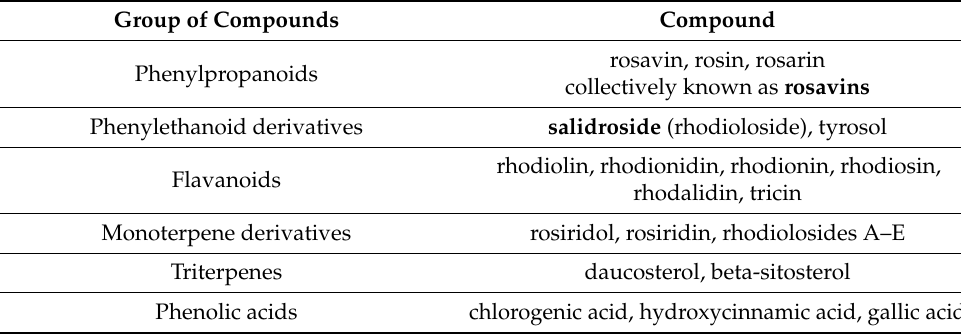
Table 1. Main phytochemicals identified in Rhodiola rosea